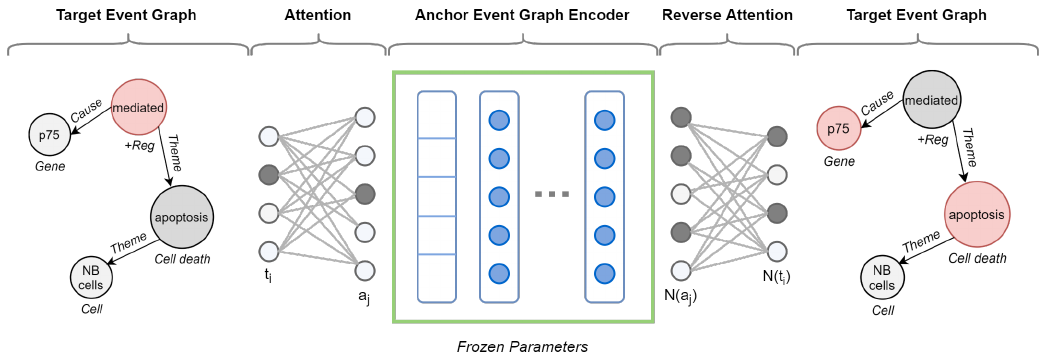
Figure 7. Anchor-based target event graph encoder for divergence prediction. Attention layers map the target event graph nodes onto the anchor graph, being aware of node and edge attributes. The first attention network ( ) receives a one-hot encoding vector representing a node ( t i ) in the M T →A target graph and maps it onto the most structurally and semantically similar node ( a j ) in the anchor graph. The anchor event graph encoder, then predicts the neighbors of a j , N ( a j ) . Finally, the reverse attention network ( ) takes N ( a j ) and maps them to the neighbors of t i , N ( t i ) M A→T